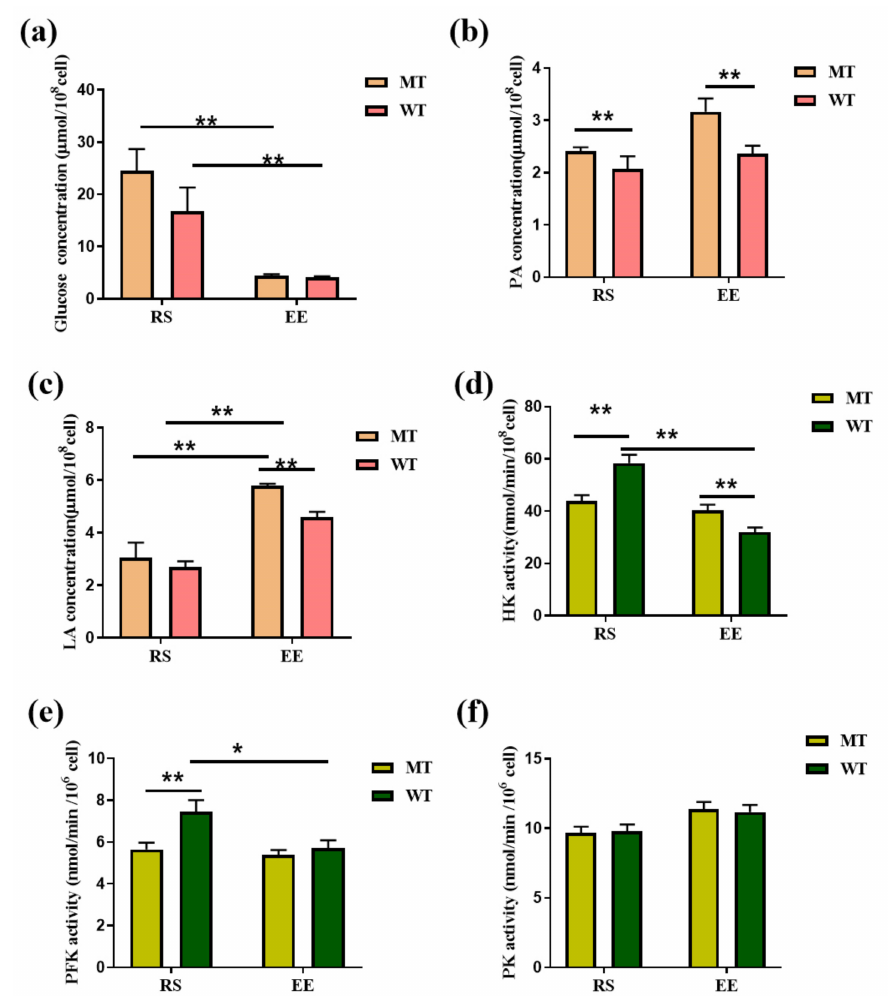
Figure 6. MSTN knockout affected glycolysis of erythrocytes. ( a ) Concentration of glucose; ( b ) Concentration of PA; ( c ) Concentration of LA; ( d ) Activity of HK; ( e ) Activity of PFK; ( f ) Activity of PK. MT: MSTN knockout cattle group; WT: Wild type cattle group; RS: Resting state; EE: Exhaustive exercise state; Data presented are means ± SD. One-way ANOVA with post hoc LSD multiple- comparison test. * p < 0.05, ** p <